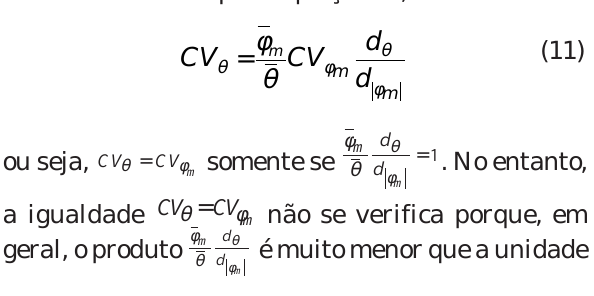
Quadro 5. Propagação da variabilidade de fffff